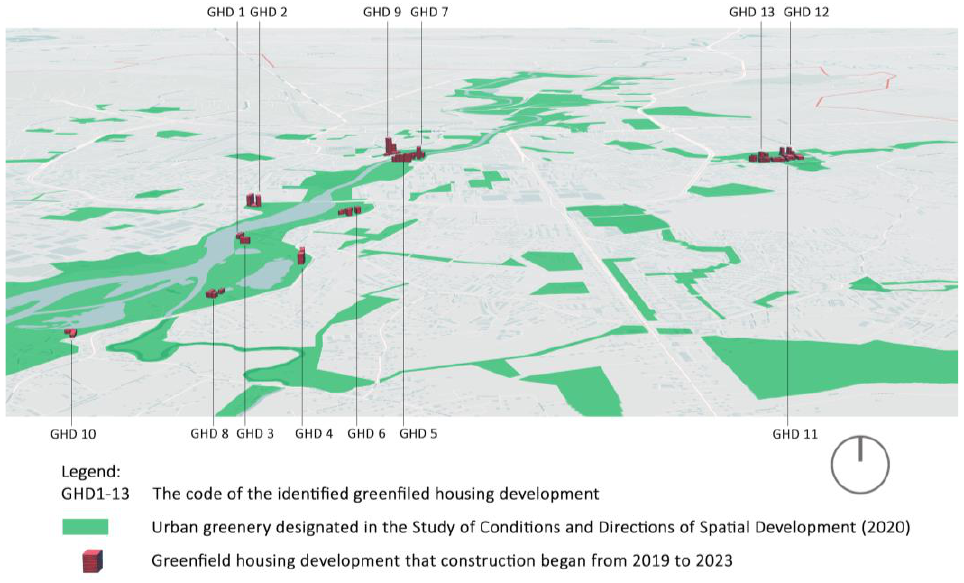
Figure 2. The distribution of GHD within UGI in Rzeszow in 2022—a perspective projection.